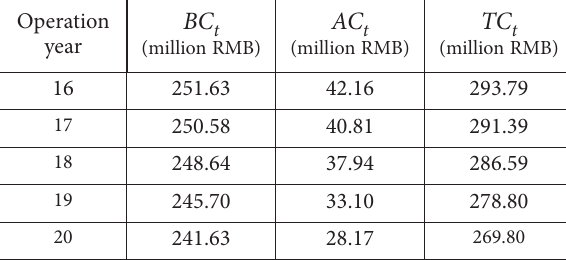
Table 3. Calculation of annual additional